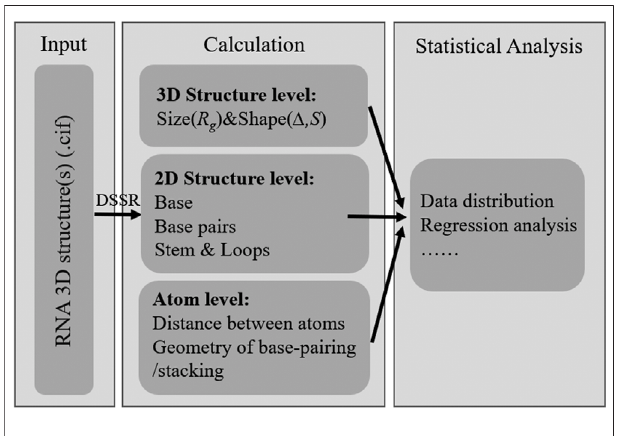
FIGURE 1 | The basic functions of RNAStat for RNA 3D structure calculation and statistical